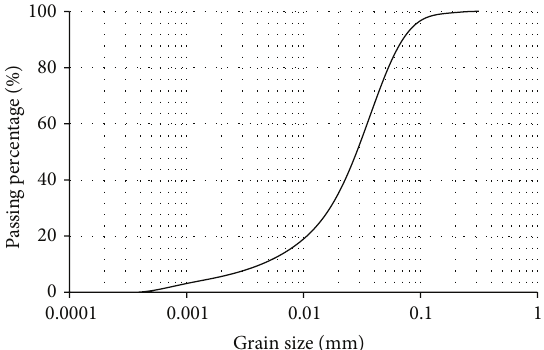
Figure 2: Grain distribution of the silty